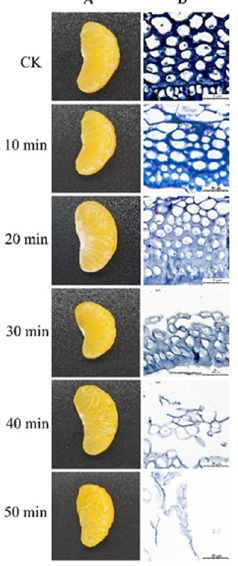
Figure 1. Degradation effect of the crude enzyme solution on citrus segments at subsequent times: ( A ) macroscopic observation and ( B ) microscopic observation by light microscopy. CK: control group.